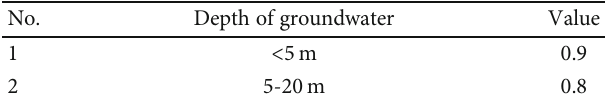
Table 6: Depth of groundwater